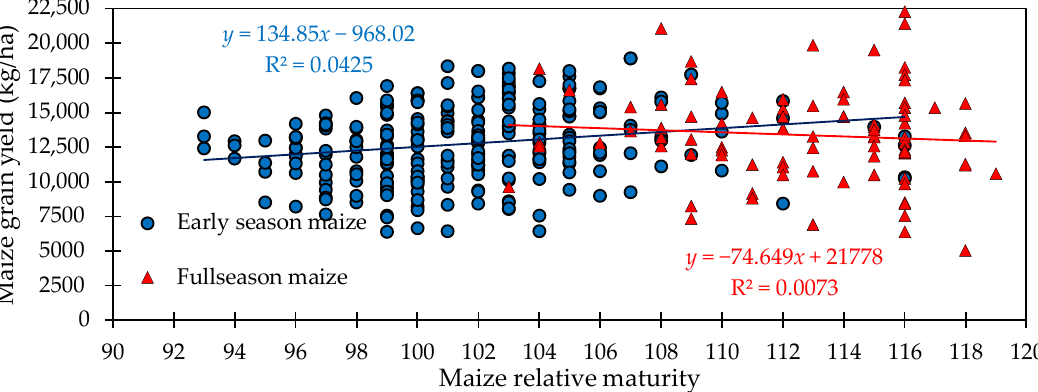
Figure 5. Relationship between maize relative maturity and maize grain yield for the full season and early season maize for the 2003 – 2019 period.